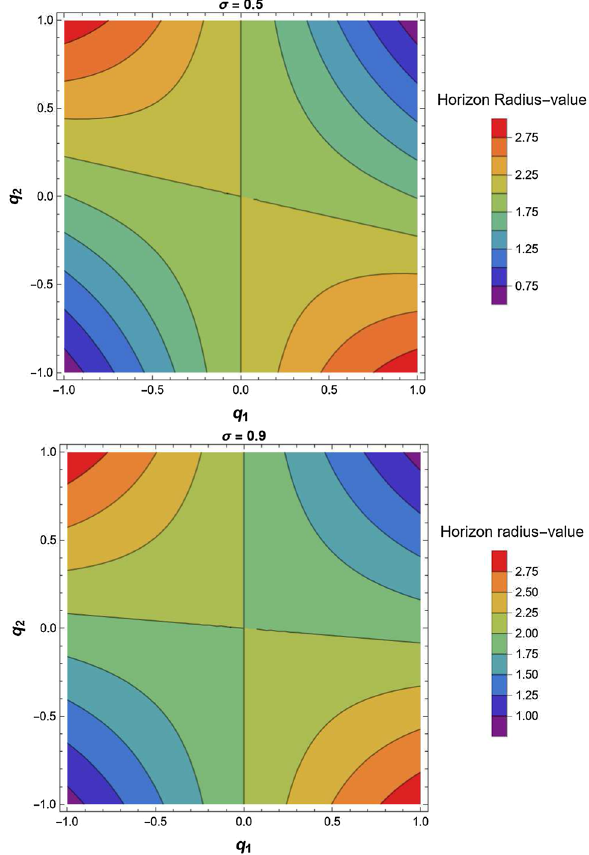
Fig. 2 The dependence of horizon radius on q 1 and q 2 for two values of σ = 0 . 5 and σ = 0 .